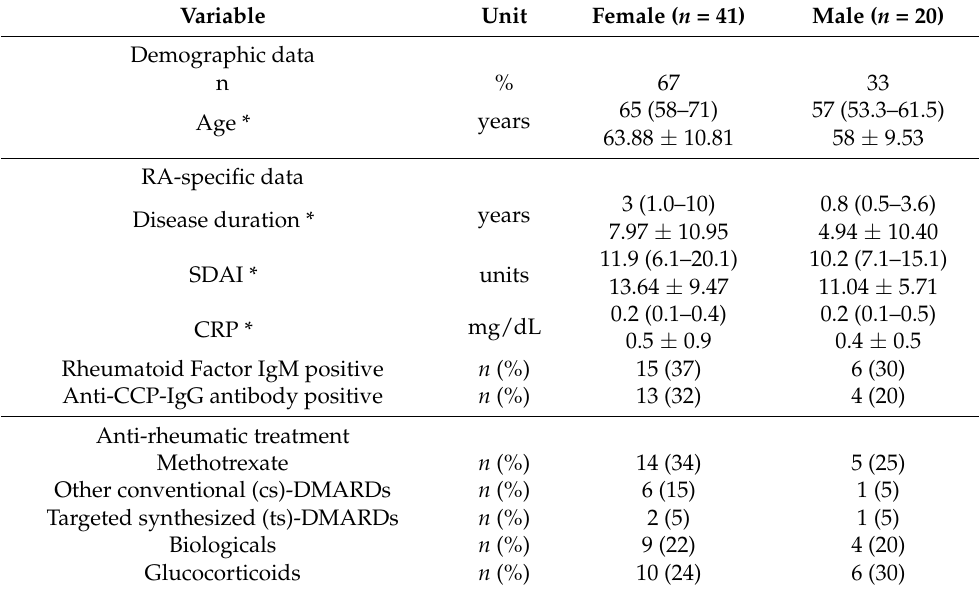
Table 1. Demographic data and current treatment of RA